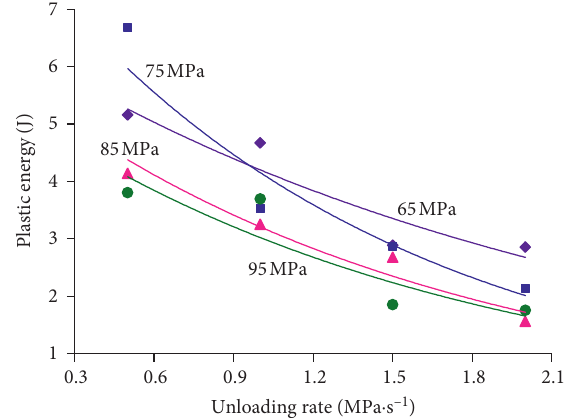
Figure 9: Relationship between the elastic energy accompanying with impact and unloading rate (the numbers in figure represents the preloaded axial static stress of specimen).